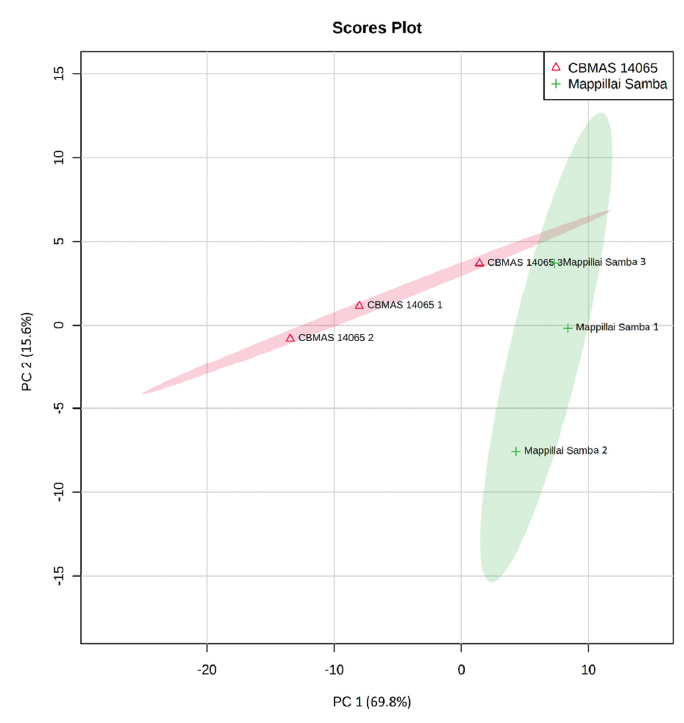
Figure 4. Principal component analysis showing the uniqueness of grain metabolomic profiles between Mappillai Samba and CBMAS 14065. PC1 explained a variation of 69.8% and PC2 explained a 15.6% variation (cumulative variance of 85.4%).